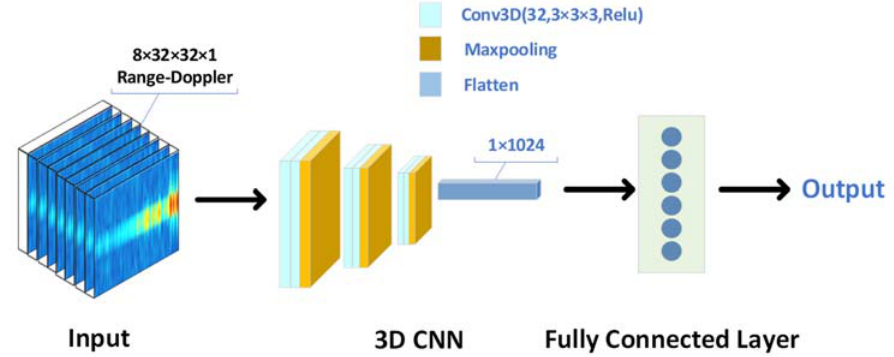
Figure 6. The structure of 3D CNN network.